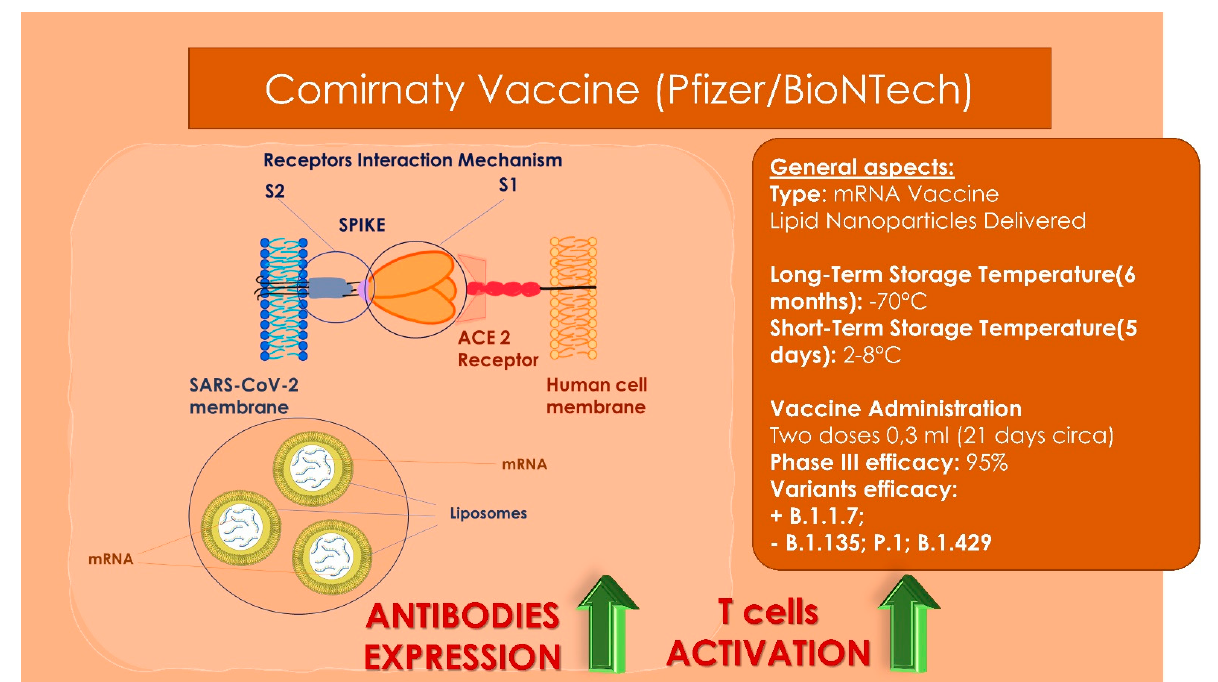
Figure 4. Pfizer/BioNTech vaccine general characteristics, storage properties, administration dosages and variants’ efficacy. High: the receptors key-to-enter interaction mechanisms between the viral vector and the human host cell membrane Lower: the lipid-based nanoparticle with the mRNA is able to enter through a cellular endosome into the human cell. Inside the cell, the ionizable lipidic component of the endosome membrane is able to become charged positively producing a release of the lipid-based nanoparticle and mRNA into the cytoplasm. Then the ribosomes is able to synthetize proteins and messengers from mRNA producing an increase of the antibodies’ expression and an activation of the T cells’ response.